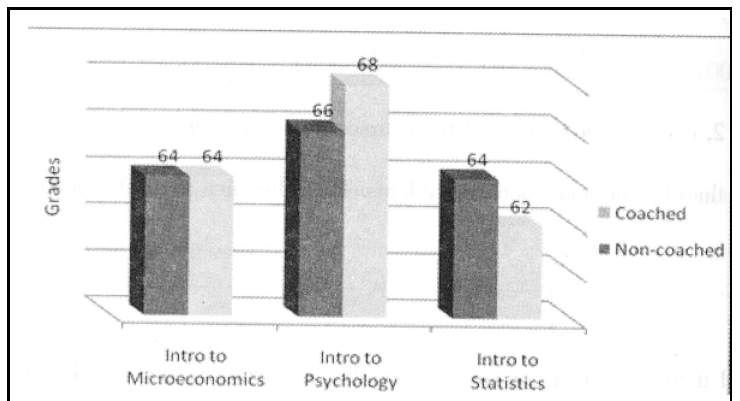
Figure 4. Average exam grade of students